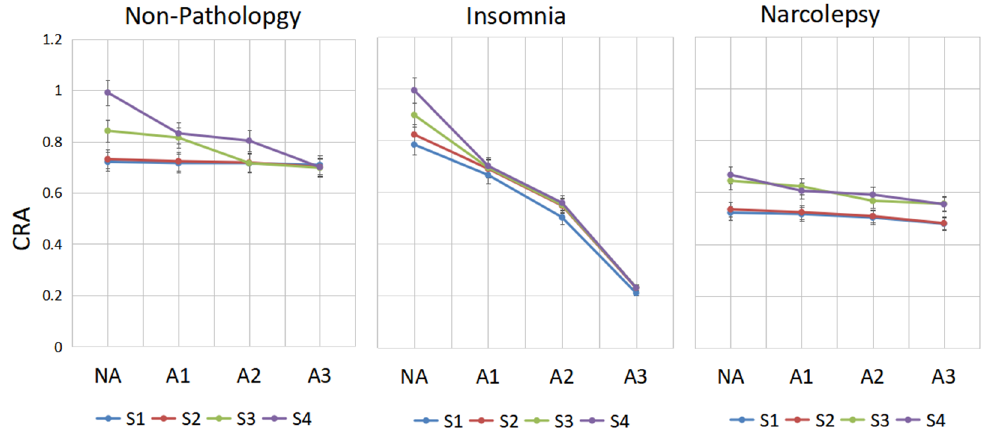
Figure 6. The change line diagram of CRA of different people in CAP. CRA in period A1-phase, A2-phase, A3-phase and NA-phase in sleep stages S1, S2, S3 and S4 are shown for every group.